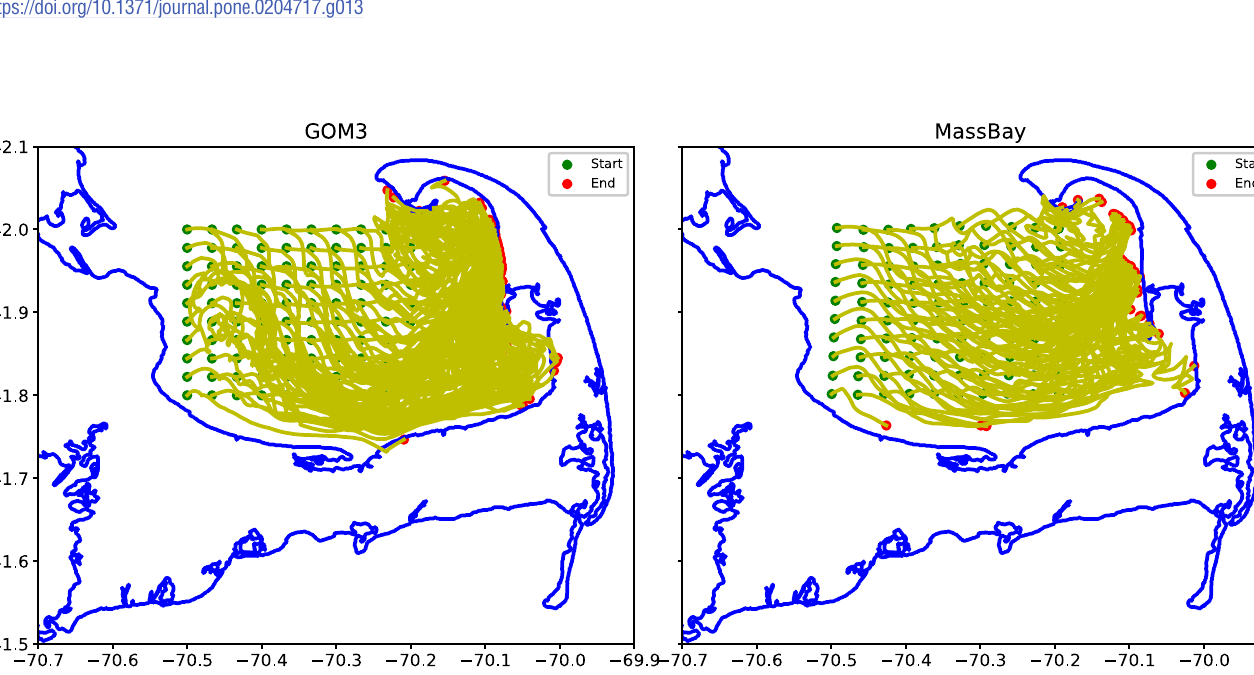
PLOS ONE | https://doi.org/10.1371/journal.pone.0204717 December4,